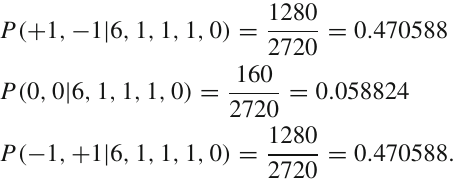
Fig. 4 An example of the path counting procedure between Alice’s and Bob’s ensemble for the priors n = 6, j 10 = 1, j 02 = 1, j 12 = 1, and m 12 = 0. Each triangle represents a subset of S 3 ( n ) (the set of all base-8 sequences) with a unique combination of eight quantum num-